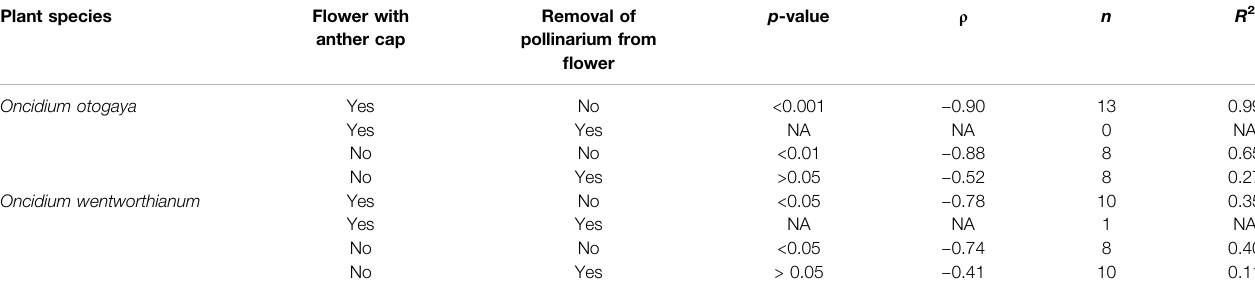
p -value Removal of anther cap pollinarium from fl ower